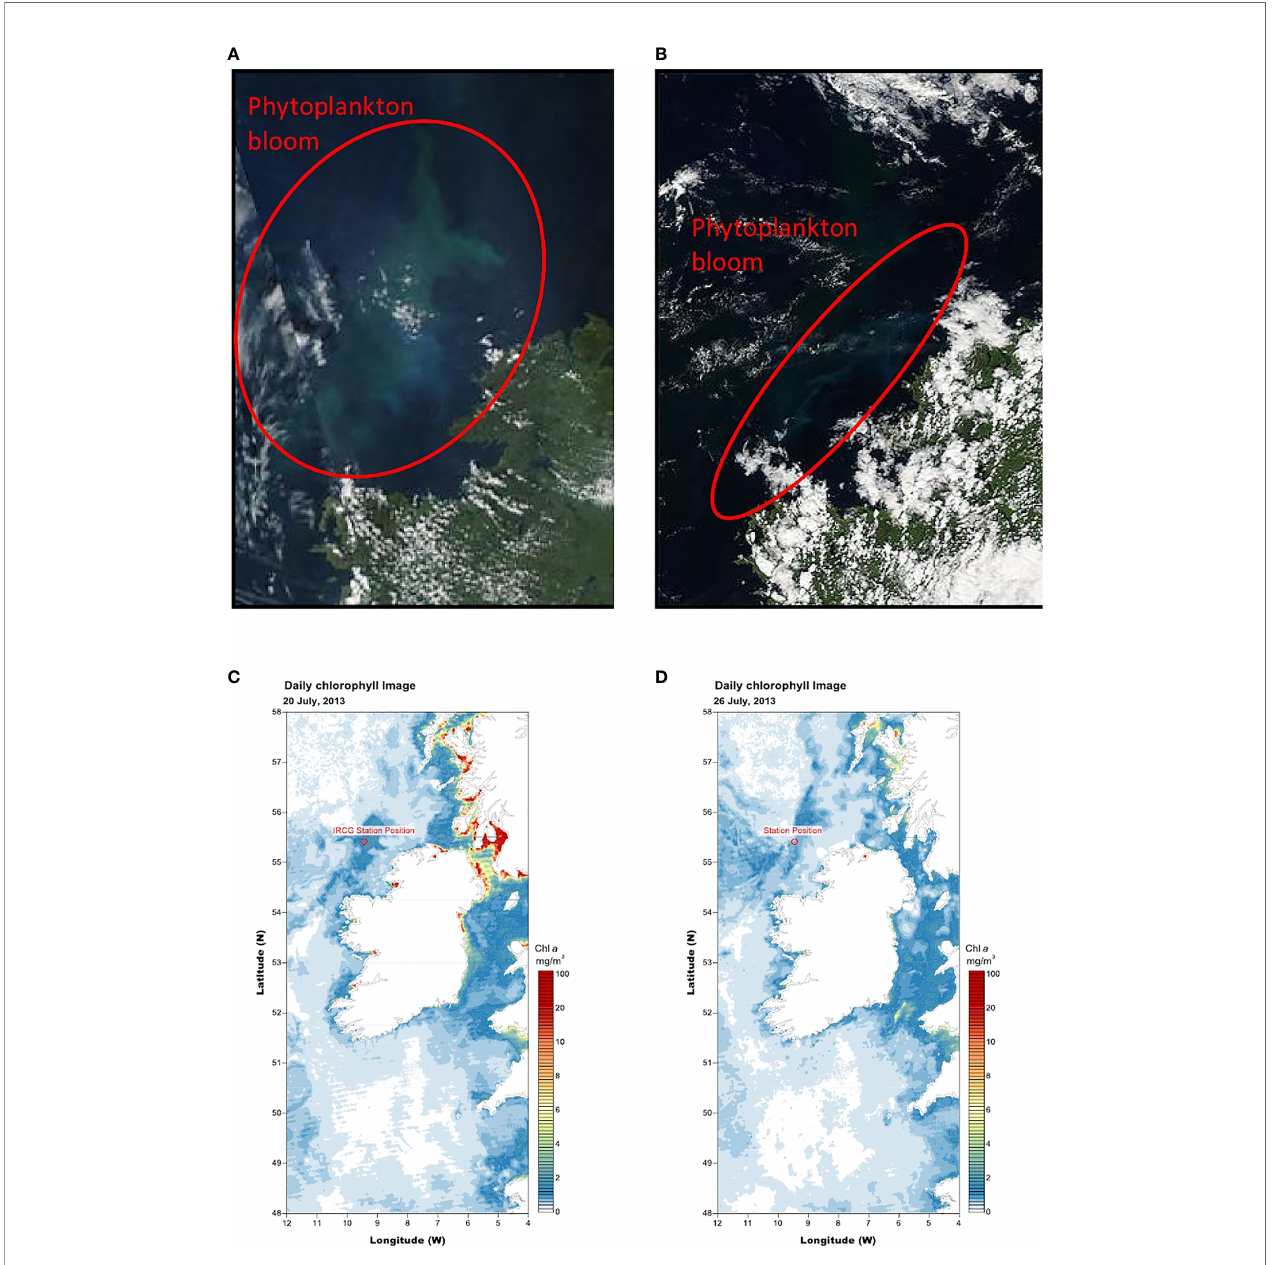
FIGURE 13 | (A) 20 th July 2013 phytoplankton bloom off northwest Ireland NASA (MODIS: Aqua); (B) 26 th July 2013 NASA (MODIS Aqua); (C) 20 th July 2013 modelled Chlorophyll data and (D) 26 th July 2013. Where (C, D) is derived from a data product from Ifremer DYNECO and CERSAT in Brest, France and NASA in the USA. The position of the station where samples were taken by the Irish Coast Guard (IRCG) is indicated in (C, D)